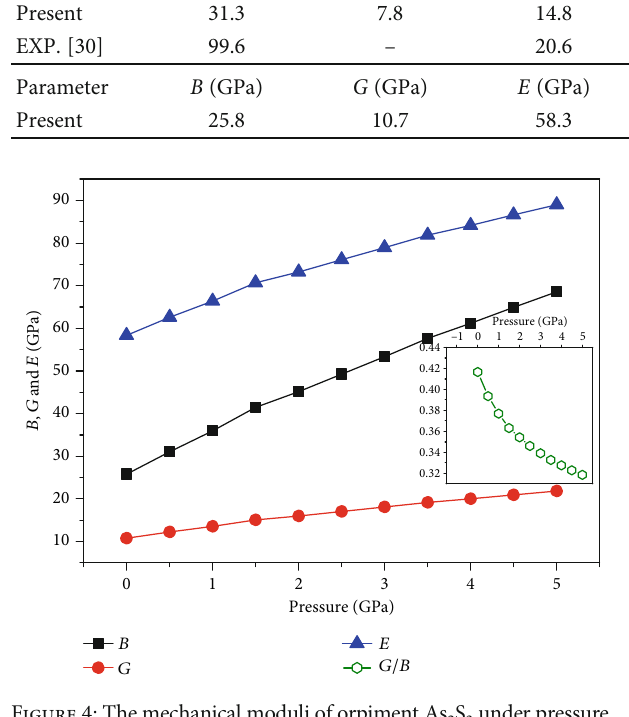
S at 0 GPa pressure. 2 3